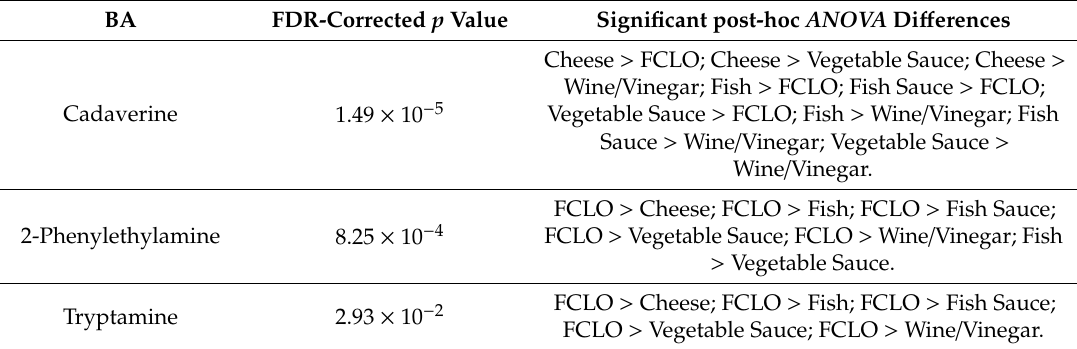
Table 7. Univariate statistical significance and nature of di ff erences observed between the mean CS-normalized, glog-transformed, and autoscaled BA contents of fermented food samples (cheese, FCLO, fish, fish sauce / paste, vegetable sauce, and wine / vinegar products) in a completely randomized, one-way ANOVA model. The significance of FDR-corrected post - hoc ANOVA tests are also provided (significant di ff erences are ranked in order of their decreasing statistical significance, i.e., increasing p value). The “between-fermented food class” source of variation was not statistically significant for putrescine, spermidine, spermine, histamine, or tyramine when tested in this model. BA FDR-Corrected p Value Significant post-hoc ANOVA Di ff erences Cheese > FCLO; Cheese > Vegetable Sauce; Cheese > Wine / Vinegar; Fish > FCLO; Fish Sauce > FCLO; Cadaverine 1.49 × 10 − 5 Vegetable Sauce > FCLO; Fish > Wine / Vinegar; Fish Sauce > Wine / Vinegar; Vegetable Sauce > Wine / Vinegar. 2-Phenylethylamine Vegetable Sauce. FCLO > Vegetable Sauce; FCLO > Wine /